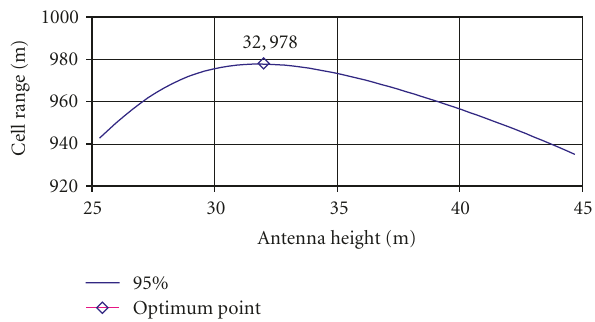
Figure 5: Cell range as function of antenna height at 95% service probability